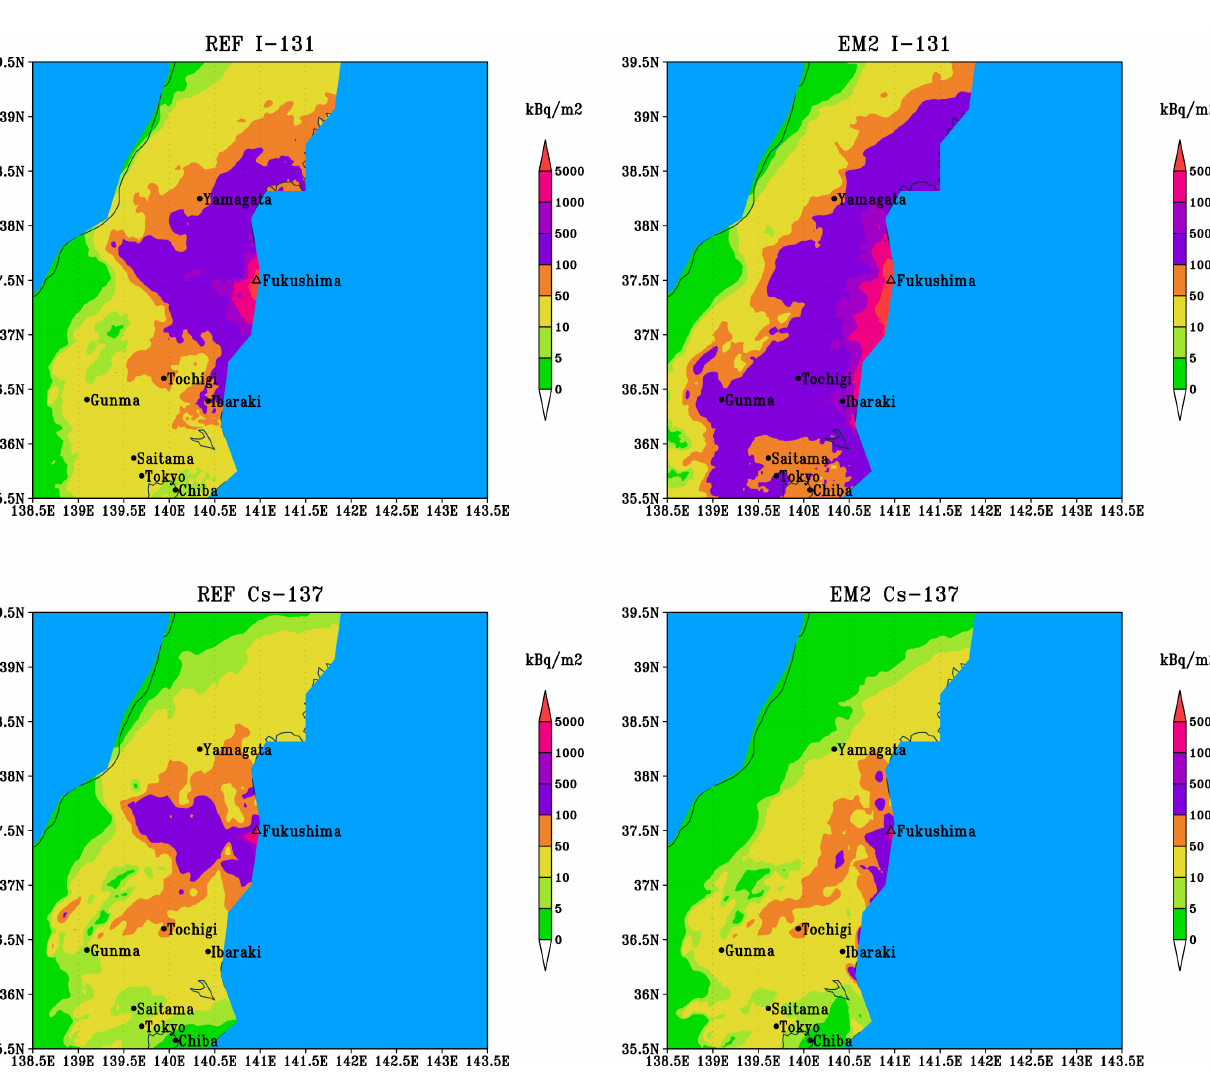
Figure 13. Distribution of accumulated total depositions of 131 I and 137 Cs over domain 2 with different emission rates. Emission rates estimated by JAEA are used in case REF and those from TEPCO are used in case